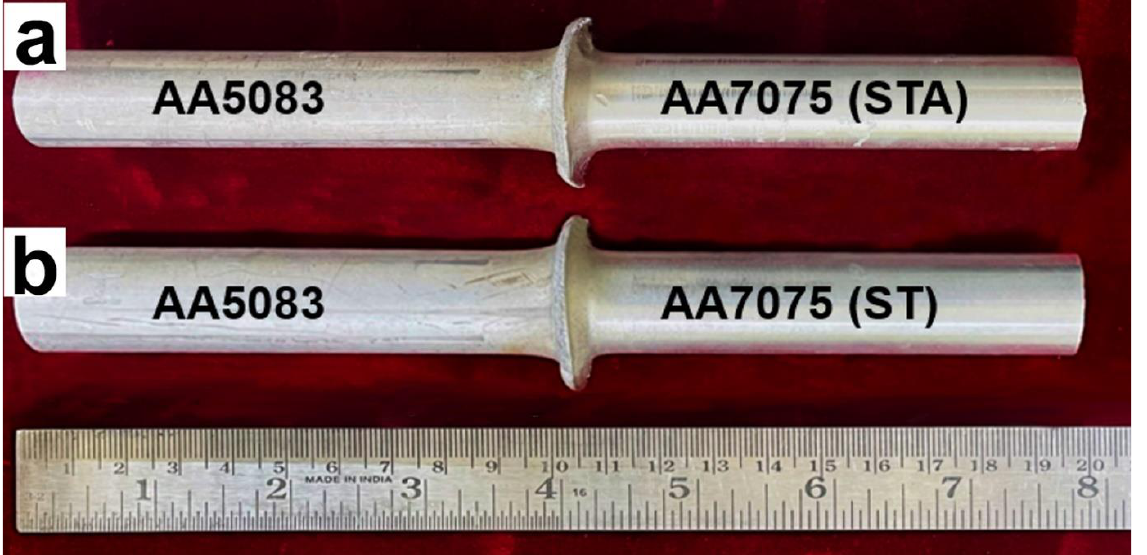
Figure 5. Visual view of welded joints ( a ) AA5083/AA7075-STA and ( b ) AA5083/AA7075-ST.